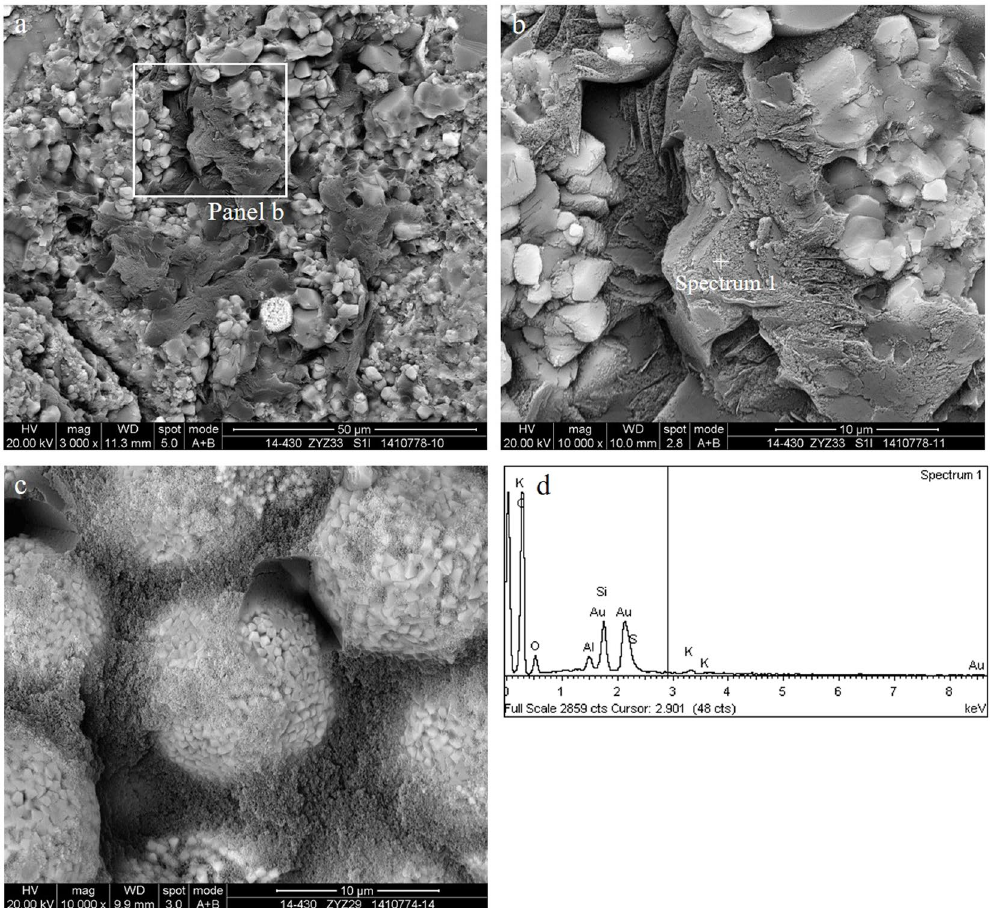
Figure 6. Bitumen in the flocculent organic matter. ( a , b ) Bitumen fills the mineral interparticle pores of the Longmaxi Formation in well Jiaoye 2 (2543.84 m). A micro-layer developed in the bitumen and is arranged in various directions. ( c ) Porous bitumen fills the framboidal pyrite of the Wufeng Formation in well Jiaoye 1 (2412.06 m). OM pores are developed in the bitumen. ( d ) The energy spectrum and elements of the